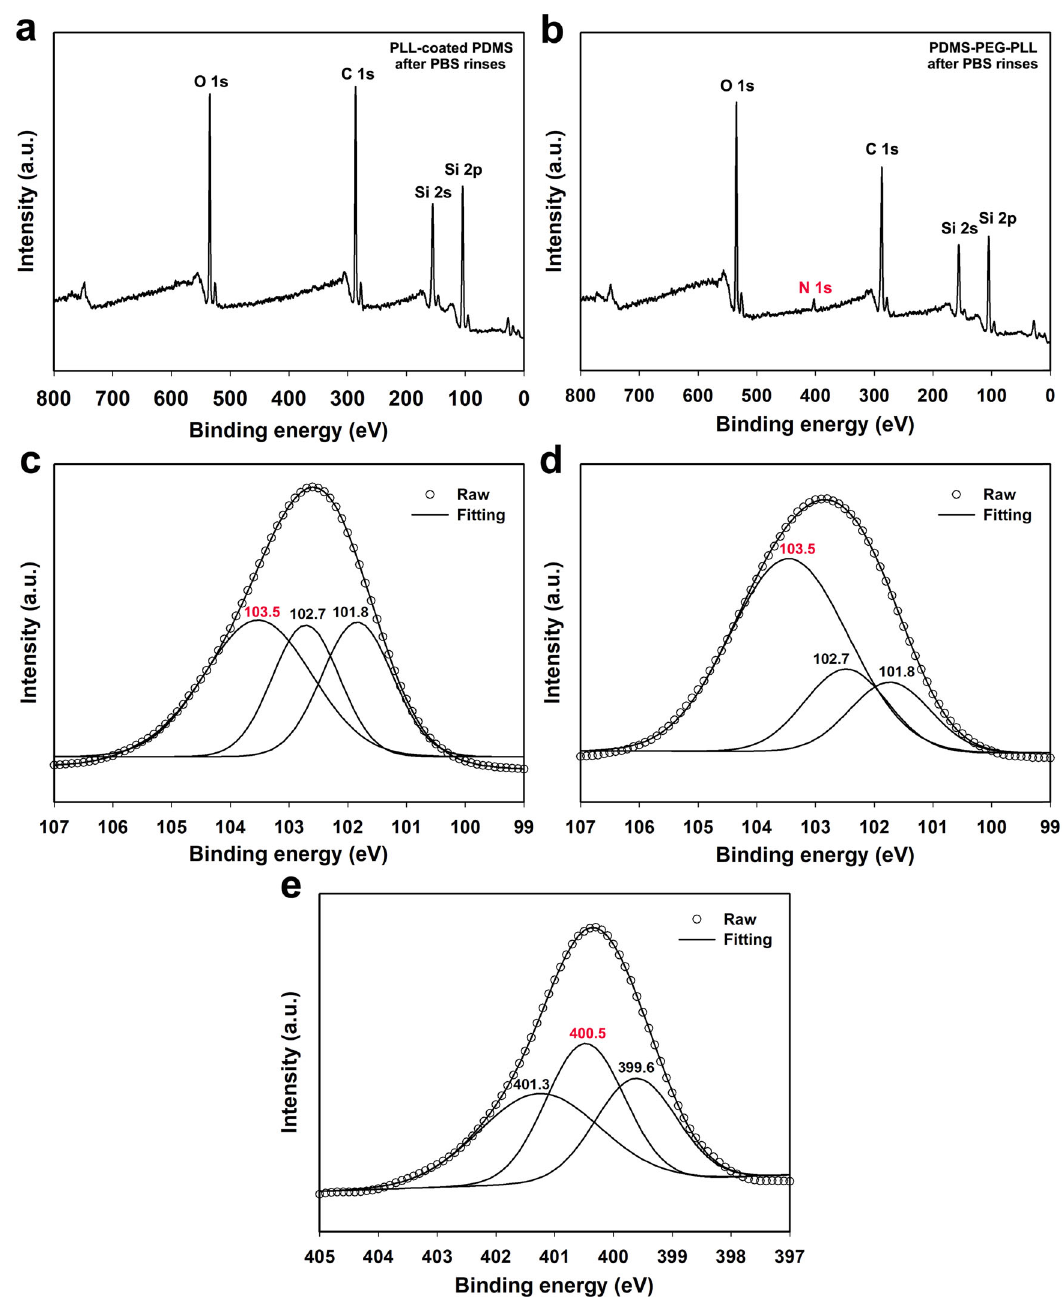
Fig. 3 XPS survey spectra of a PLL-coated PDMS after PBS rinses and b PDMS-PEG-PLL with PEG 600 after PBS rinses. High-resolution Si 2 p XPS spectra for c PDMS and d PDMS-PEG-PLL. e High-resolution N 1 s XPS spectrum for